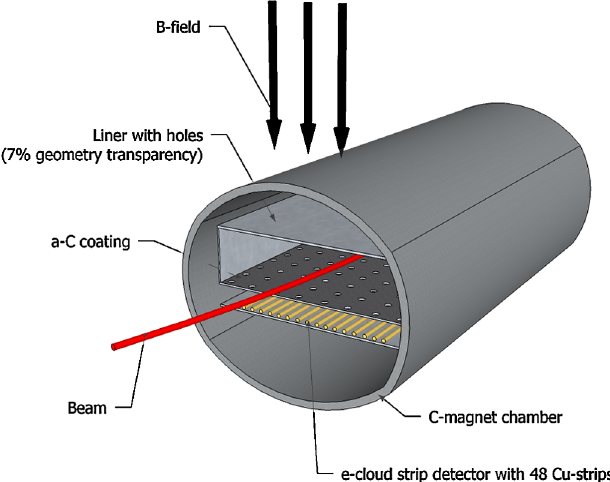
FIG. 1. The schematic view of the liner used for e-cloud